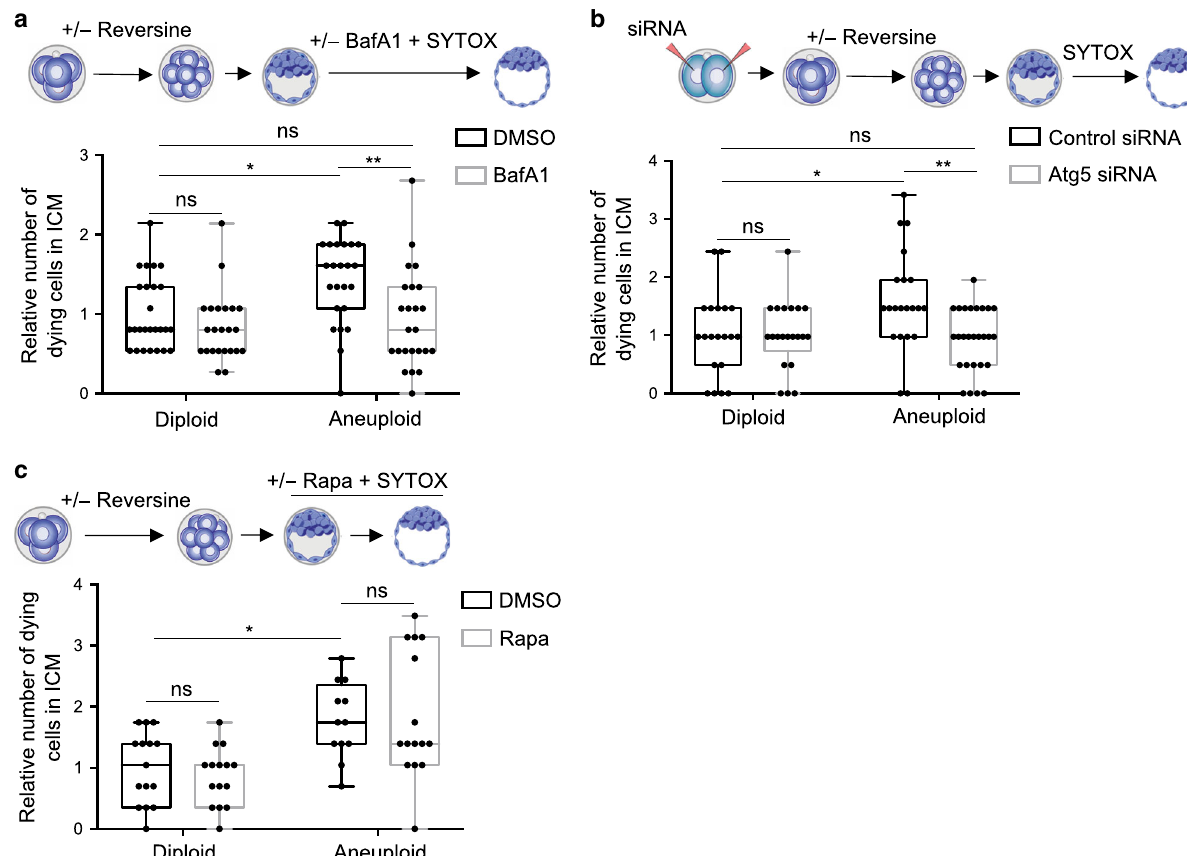
Fig. 5 Autophagy upregulation mediates cell death in the ICM of aneuploid pre-implantation embryos. a Diploid and aneuploid embryos were imaged with Ba fi lomycin A1 (BafA1) or DMSO and SYTOX from the early to late blastocyst stage (24 h). The number of dying ICM cells was assessed relative to the average number of dying cells in DMSO-treated diploid ICMs. Diploid n = 26 embryos, aneuploid n = 24 embryos, diploid BafA1 n = 23 embryos, aneuploid BafA1 n = 24 embryos. Kruskal – Wallis test, * p = 0.0435, ** p = 0.0050. b Two-cell stage embryos were injected with Atg5 siRNA or control siRNA, treated at the four- to eight-cell stage with reversine or DMSO, and imaged with SYTOX during blastocyst maturation (24 h). The number of dying ICM cells was assessed relative to the average number of dying cells in control siRNA-injected diploid ICMs. Diploid n = 20 embryos, aneuploid n = 21 embryos, diploid Atg5 siRNA n = 21 embryos, aneuploid Atg5 siRNA n = 27 embryos. One-way ANOVA test, * p = 0.0374, ** p = 0.0068. c Diploid (DMSO-treated) and aneuploid (reversine-treated) embryos were treated with DMSO or rapamycin (Rapa) from the early to the late blastocyst stage (24 h) and imaged in the presence of SYTOX to label dying cells. Diploid n = 15 embryos, aneuploid n = 12 embryos, diploid rapa n = 15 embryos, aneuploid rapa n = 15 embryos. One-way ANOVA test, * p = 0.0358. For all the graphs, data are shown as individual data points in a Box and Whiskers graph (bottom: 25%; top: 75%; line: median; whiskers: min to max), ns not signi fi cantly different. Source data are provided as a Source Data fi